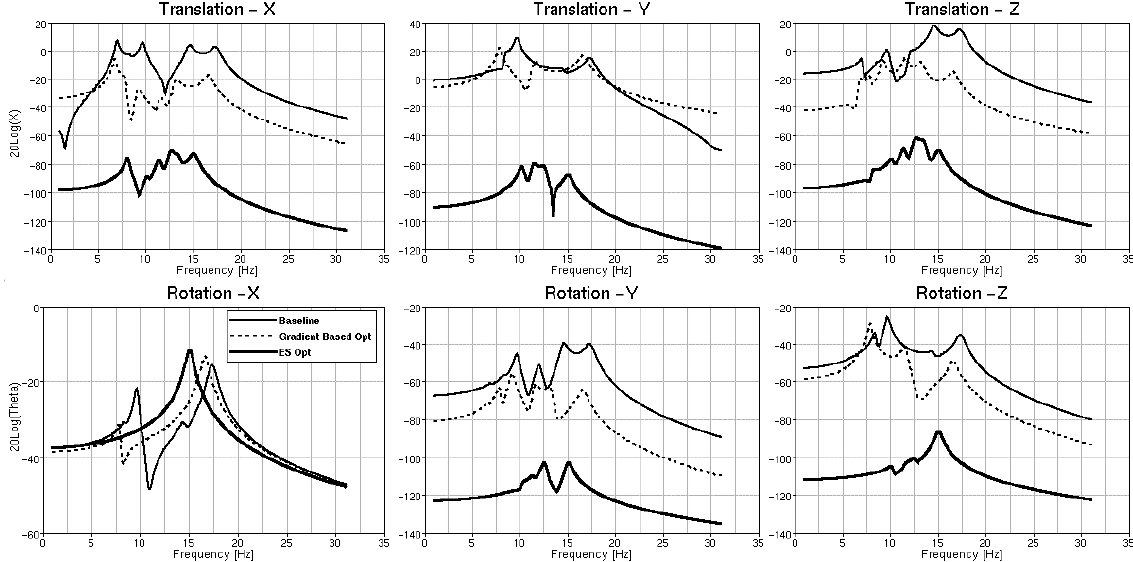
Fig. 8. CG response of the rigid powertrain by itself in TRA co-ordinate system due to a unit torque about the crank-shaft axis. The ES optimized roll-mode response (Rotation-X) is completely